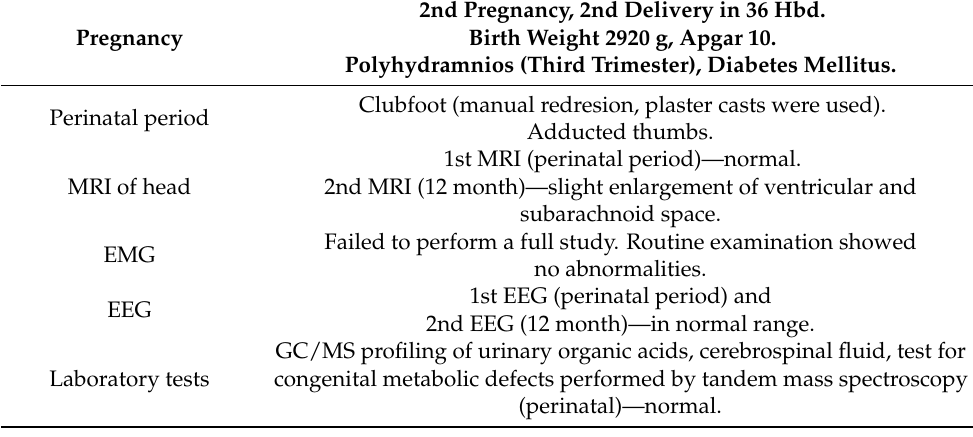
Table 1. Clinical characteristics of the patient with CLIFAHDD